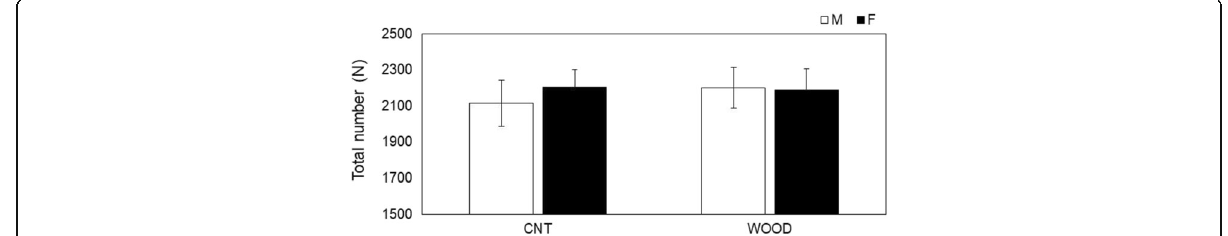
Fig. 1 Rate of correct calculations during arithmetic work. Rate of correct calculations during arithmetic work. The bars represent the rate of correct calculations in the control condition (left) and Japanese cedar wood panels (experimental; light) conditions. CNT indicates the control condition, while WOOD indicates the experimental condition: male participants (white) and female participants (black). Differences between both conditions were not significant. Data are shown as mean ±